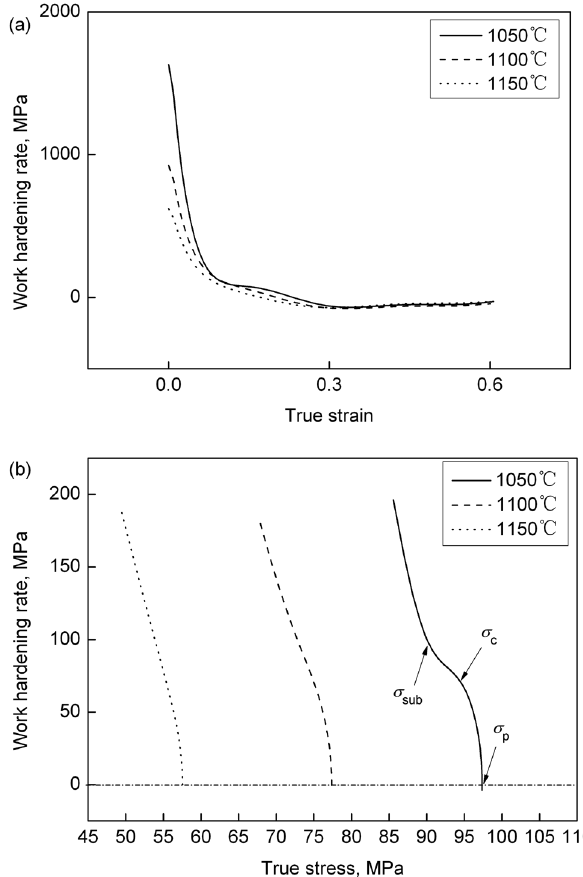
Fig. 7: Curves of working hardening rate versus (a) true strain and (b) true stress deformed at 0.01 s − 1 and different